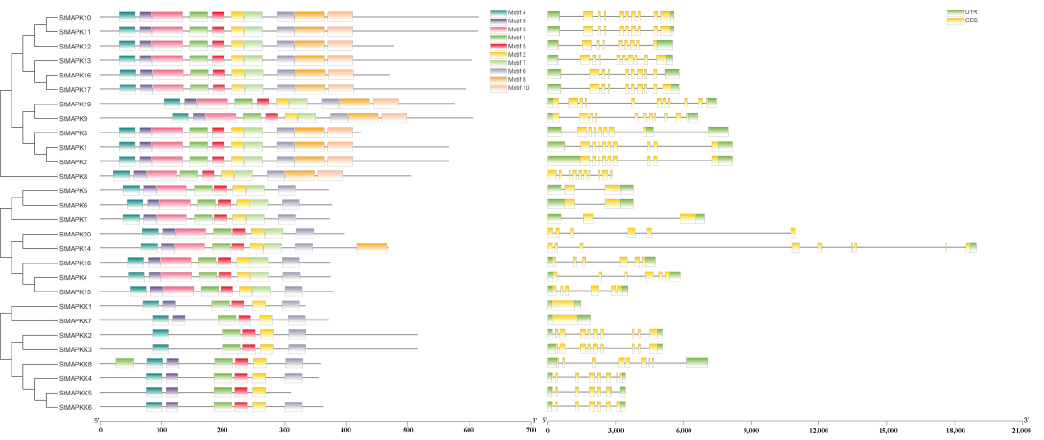
Figure 3. Analysis of gene structure and conserved motifs of potato MAPK and MAPKK gene